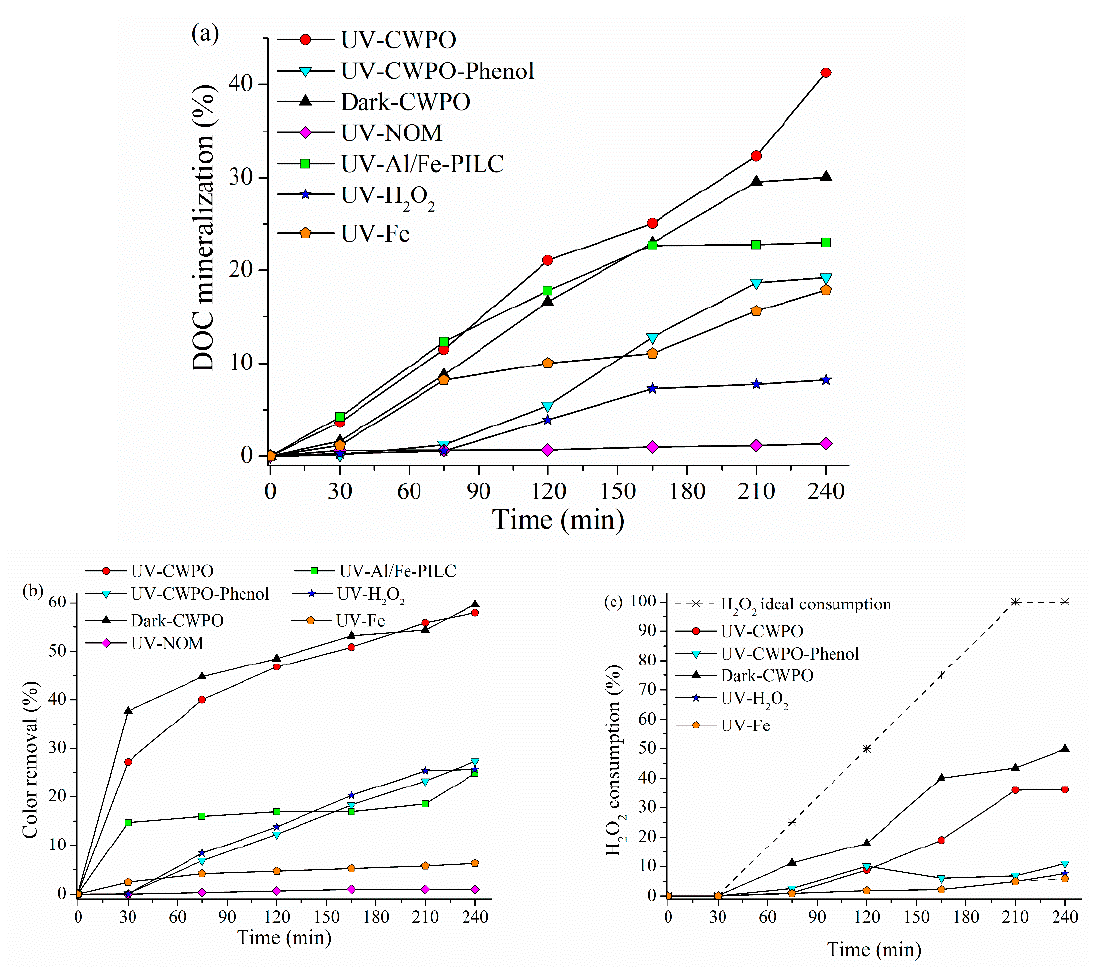
Figure 3. Photo-CWPO degradation of NOM (or phenol) under UV irradiation: ( a ) DOC mineralization, ( b ) color removal and ( c ) H 2 O 2 consumption. UV light source λ = 365 nm; [DOC] 0 : 7.0 mg C/dm 3 either represented from NOM surrogate or phenol; H 2 O 2 dose: 3.77 mg H 2 O 2 /mg C (30 mg H 2 O 2 /dm 3 ); [Al/Fe-PILC]: 3.81 g/dm 3 ; [Fe 2+ ] 0 in UV-Fe experiment: 65 mg/dm 3 ; pH 0 : 7.0; T: 20.0 ± 1.0 ◦ C; ambient pressure 100 kPa; Fe leaching < 0.1 mg/dm 3 .